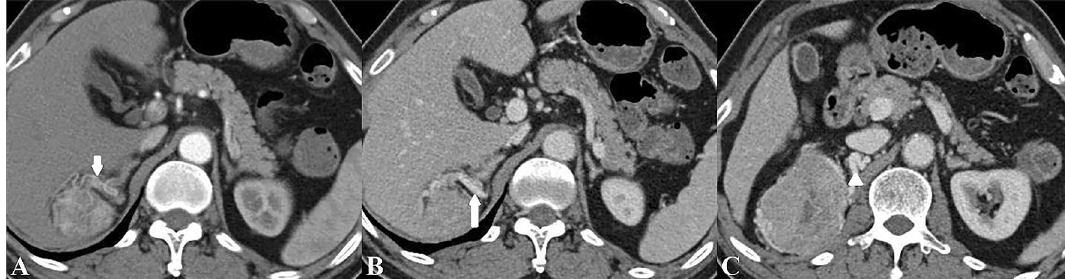
Figure 2. A 70-year-old man with a 7.3 cm clear cell carcinoma in the right kidney. Contrast-enhanced computed tomographic images demonstrate a prominent peritumoral collateral artery (short arrow) during the corticomedullary phase ( A ) and collateral vein (long arrow) during the nephrographic phase ( B ) in the right perinephric space. The collateral vein during the nephrographic phase ( C ) measures 0.5 cm in